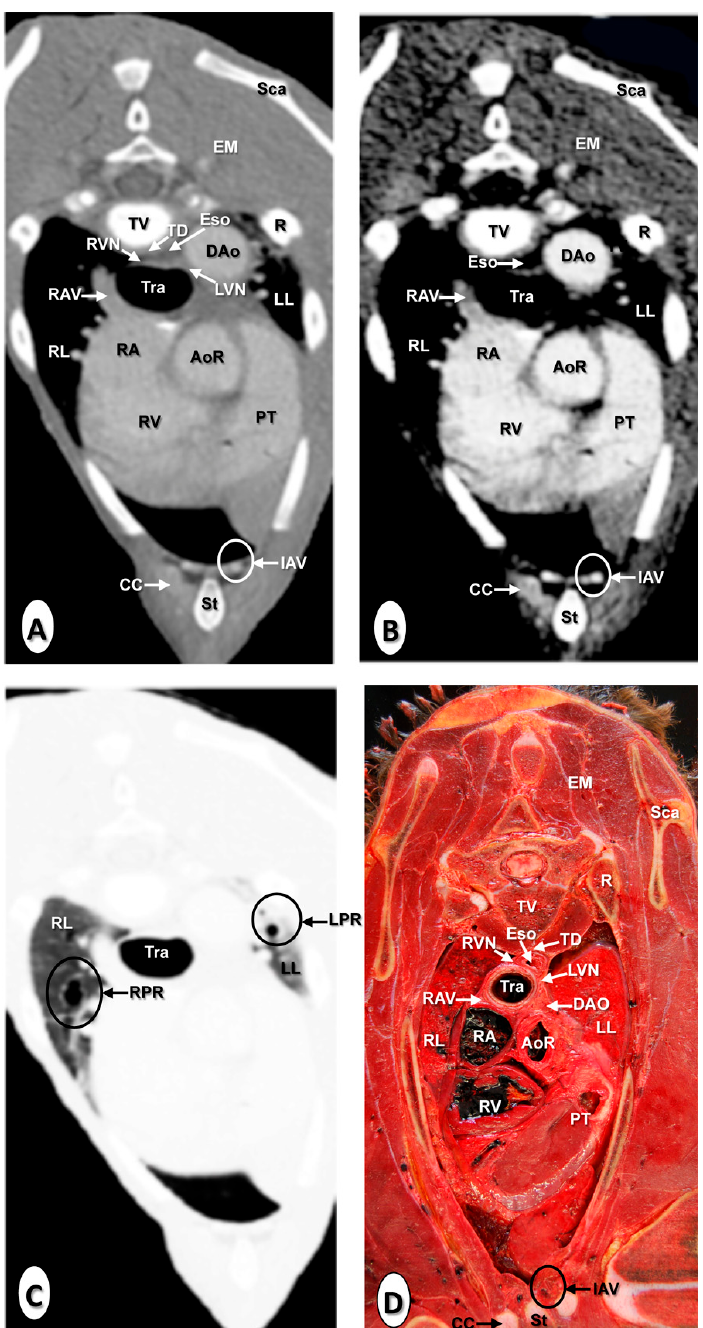
Figure 3. Transverse images at the level of the pulmonary trunk. ( A ) CT bone window; ( B ) CT mediastinal window; ( C ) CT lung window; and ( D ) anatomical section. These images are displayed so that the right side of the foal is to the viewer’s left and the dorsal view is at the top. Aortic root (AoR); descending aorta (Dao); epaxial muscles (EM); esophagus (Eso); internal thoracic artery and vein (IAV); left lung (LL); left pulmonary root (LPR); left vagus nerve (LVN); pulmonary trunk (PT); rib: Costal bone (R); rib: Costal cartilage (CC); right atrium (RA); right azygos vein (RAV); right lung (RL); right pulmonary root (RPR); right vagus nerve (RVN); right ventricle (RV); scapula (Sca); sternum (St); thoracic duct (TD); thoracic vertebra (TV); and trachea (Tra).